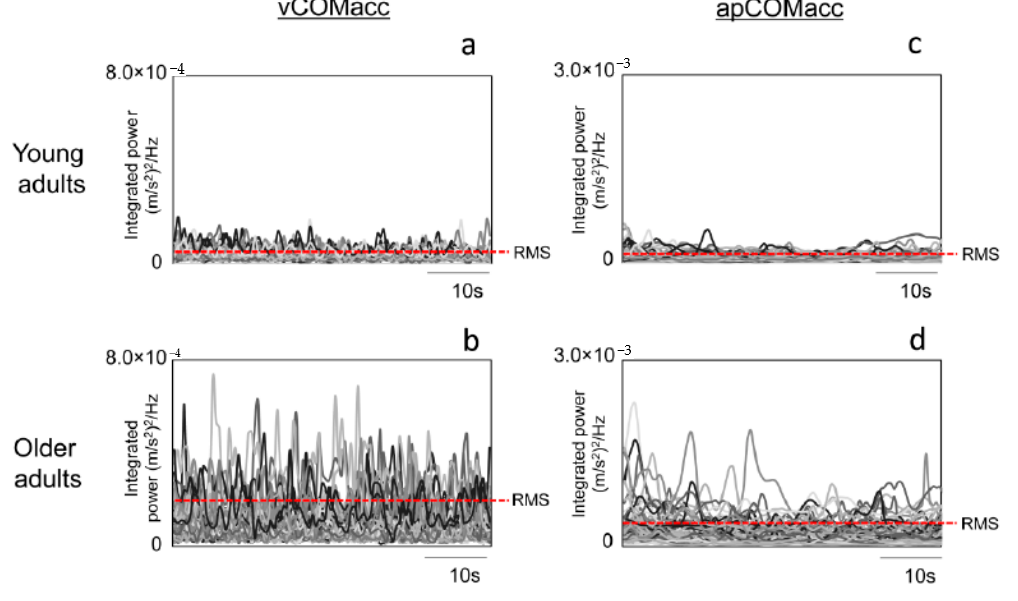
Figure 4. Superposition time-series waveforms of young (panels ( a , c )) and older adults (panels ( b , d )) for vCOMacc (left panel) and apCOMacc (right panel) of the continuous wavelet time–frequency spectrum (time-integral squared amplitude power) during quiet standing. The dotted line in the figure shows the root mean square